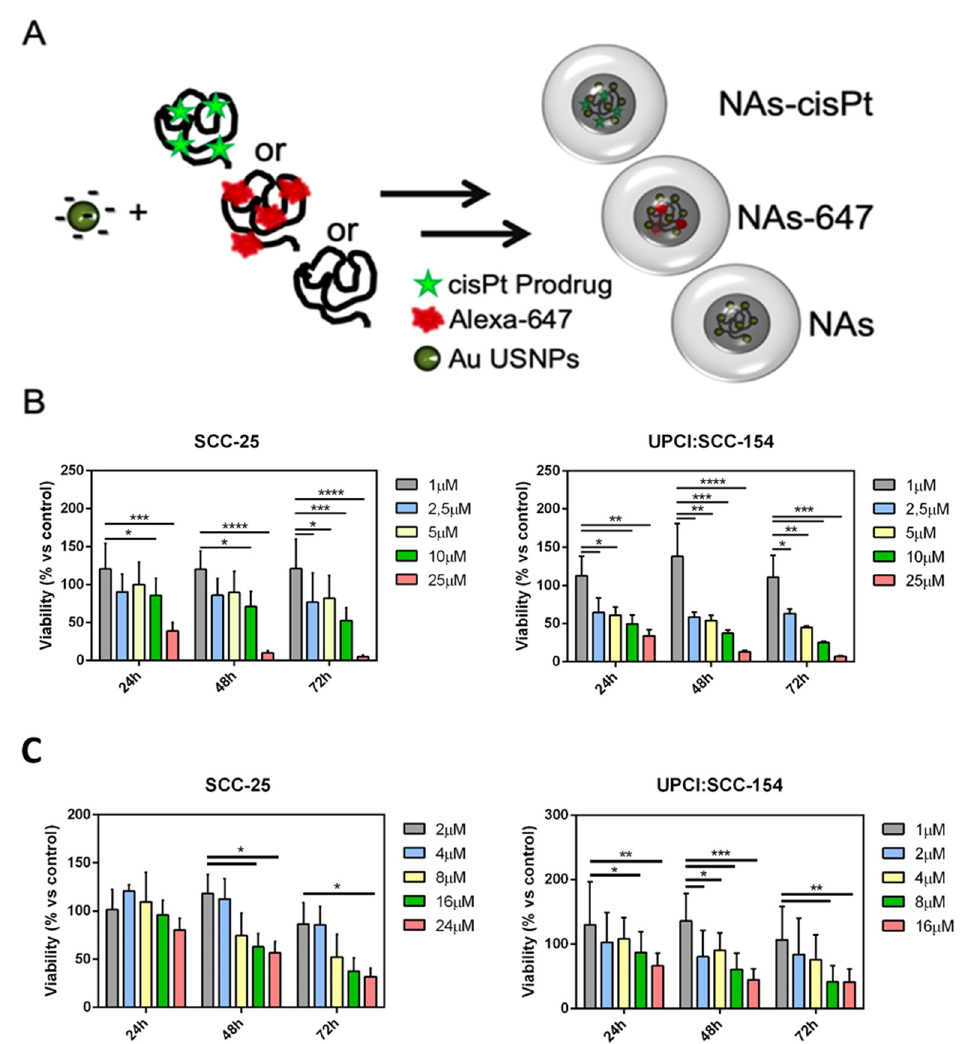
Figure 1. Structures of NAs and cytotoxic e ff ect of cisplatin-loaded nano-architectures (NAs) against SCC-25 and UPCI:SCC-154. ( A ) Cartoon depicting the production protocol of the three kinds of NAs employed in this work. Each cell line was treated with increasing concentrations of ( B ) free cisplatin or ( C ) NAs-cisPt, for 2 h at 37 ◦ C and 5% of CO 2 . Cells viability was measured at 24 h, 48 h and 72 h after treatment, and data were normalized to the viability of control cells (treated only with medium). Concentrations in the graph correspond to the active cisplatin comprised in NAs-cisPt. Results are the average of three independent experiments and error bars state the standard deviation. Two-way ANOVA Dunnett’s test for ( B ) vs. 1 µ M, (* p ≤ 0.05, ** p ≤ 0.01, *** p ≤ 0.001 and **** p ≤ 0.0001) and for ( C ) vs. 2 µ M or 1 µ M for SCC-25 and UPCI:SCC-154 respectively, (* p < 0.05, ** p ≤ 0.01 and *** p ≤